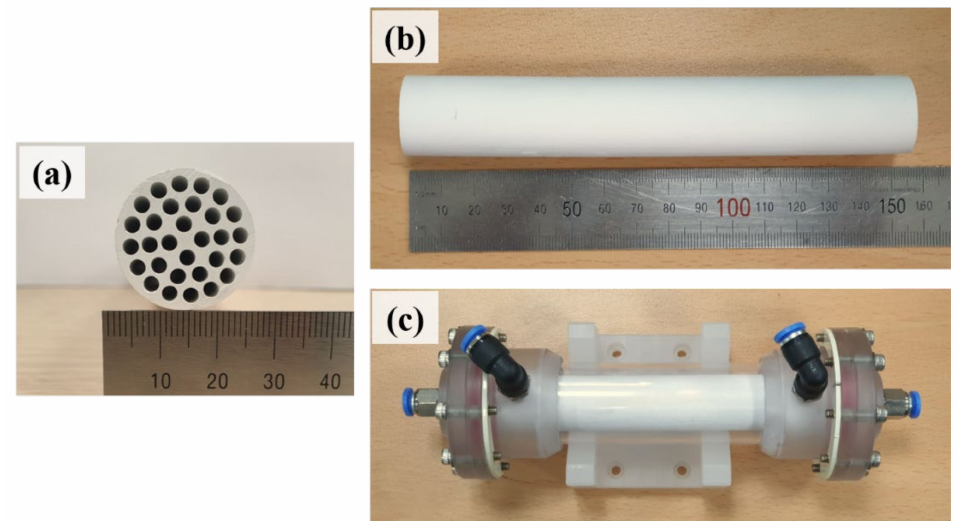
Figure 6. ( a , b ) Images of multichannel cylindrical-tube-type microfiltration filter. ( c ) Image of microfiltration filter mounting module for water permeability